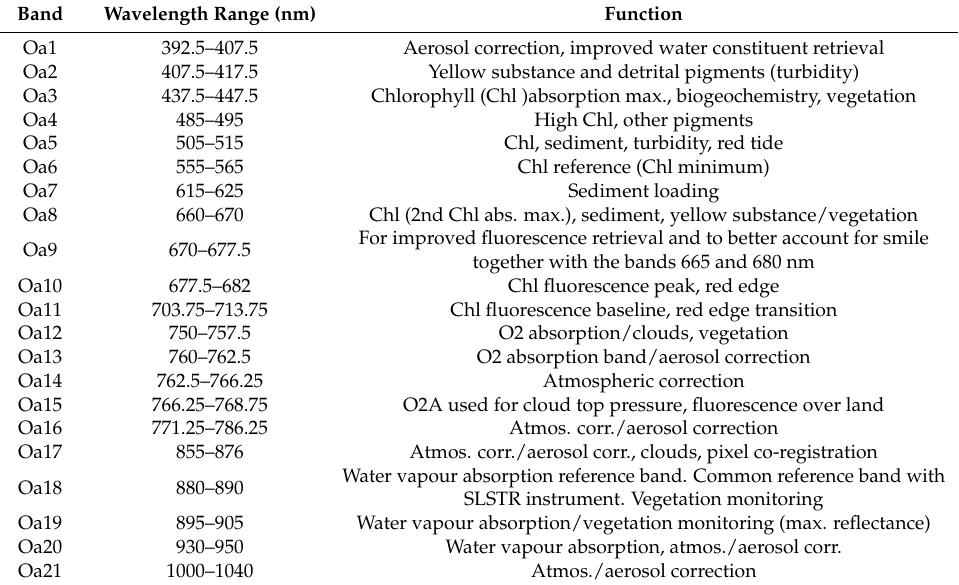
Table 1. Band characteristics of the Sentinel-3 OLCI. (Source: Sentinel-3 User